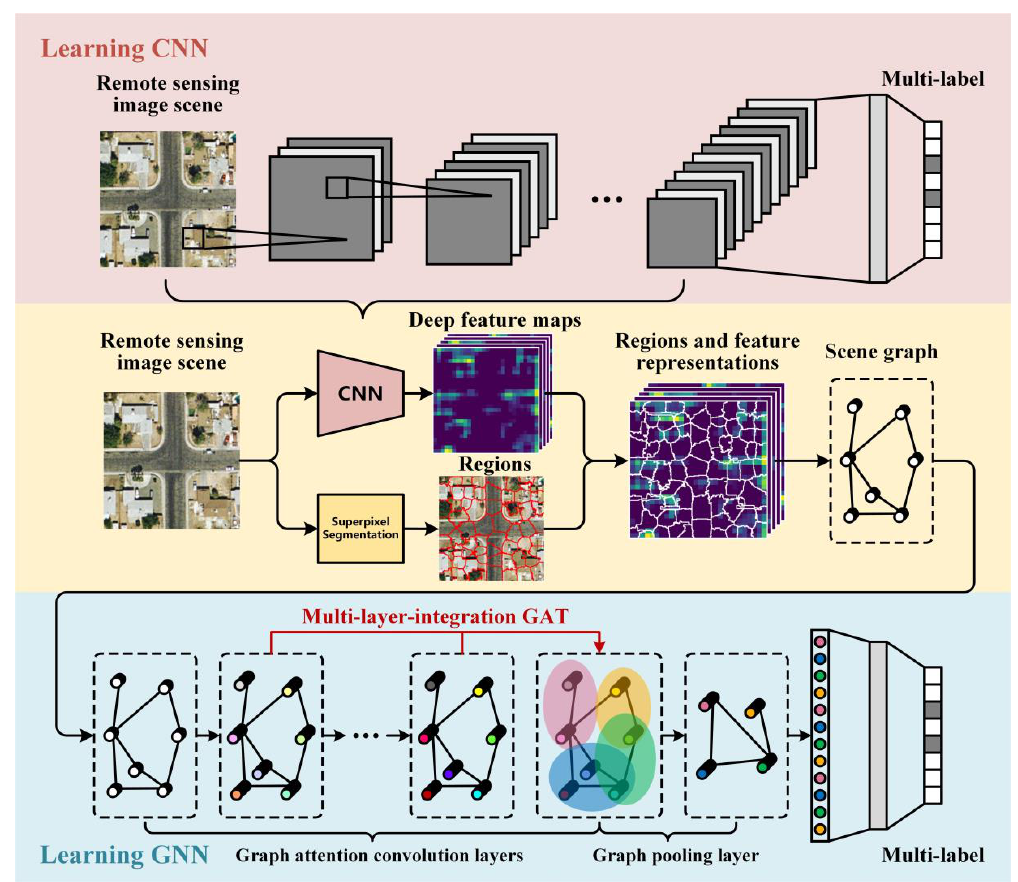
Figure 1. Overview of the proposed MLRSSC-CNN-GNN framework.